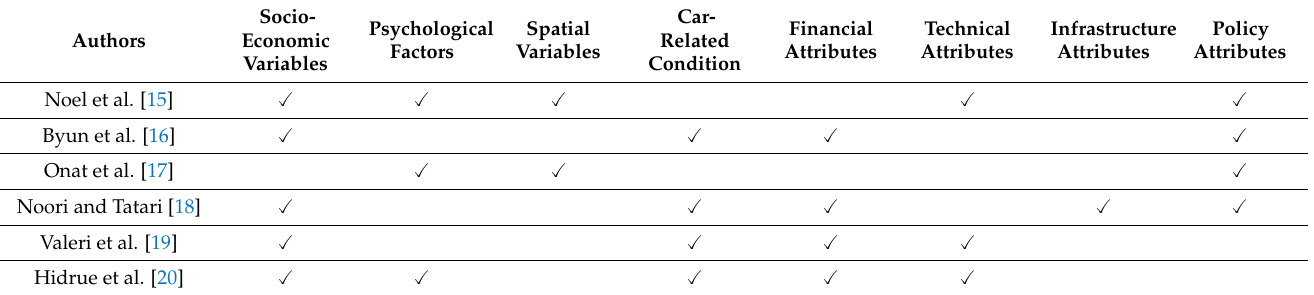
Table 1. Factors affecting purchasing